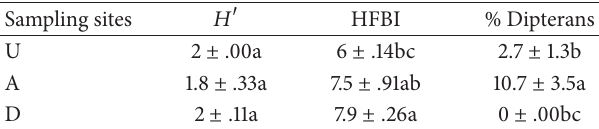
Table 2: Number of aquatic macroinvertebrates collected from study sites.